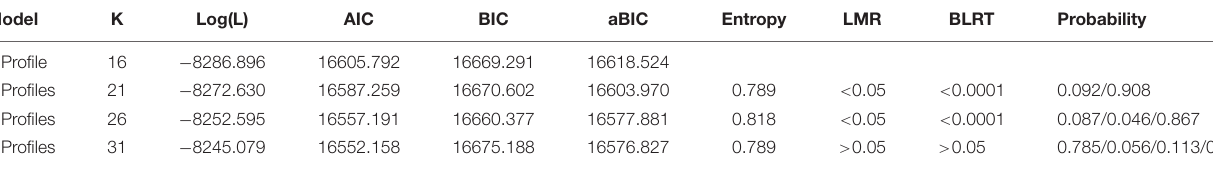
TABLE 5 | Fit indexes of LGMMs for the positive